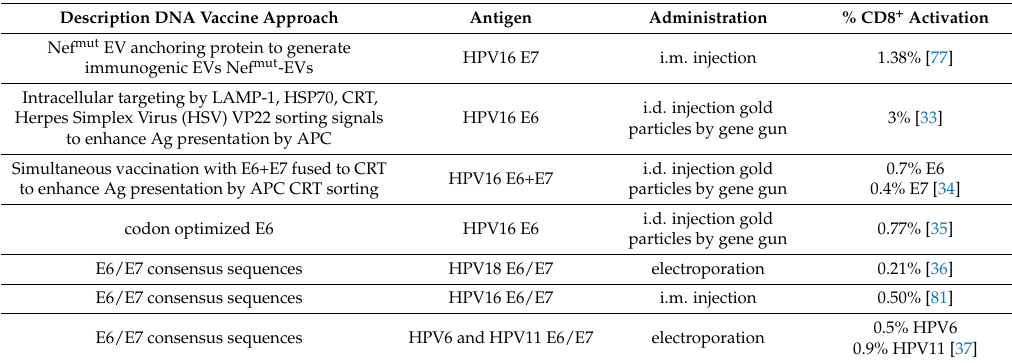
Table 4. Percentage of CTL activation associated with DNA-based HPV therapeutic vaccines in mice. EV: extracellular